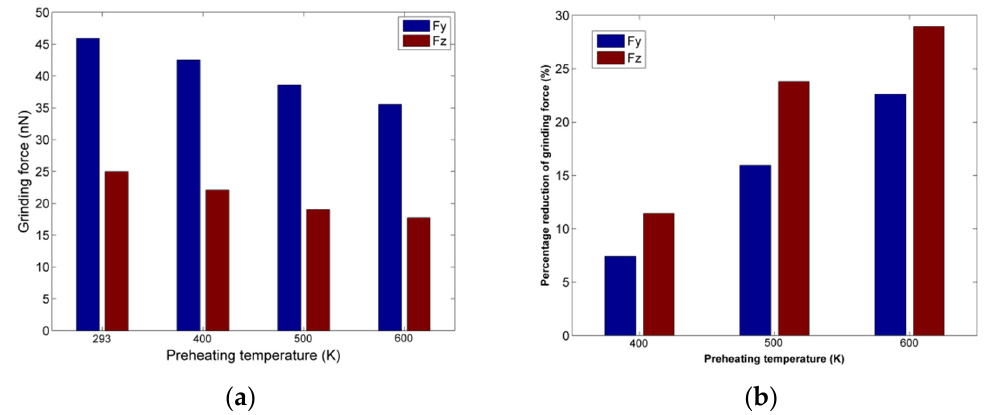
Figure 11. ( a ) Grinding forces values for different preheating temperatures; ( b ) percentage of grinding forces reduction at different preheating temperatures.